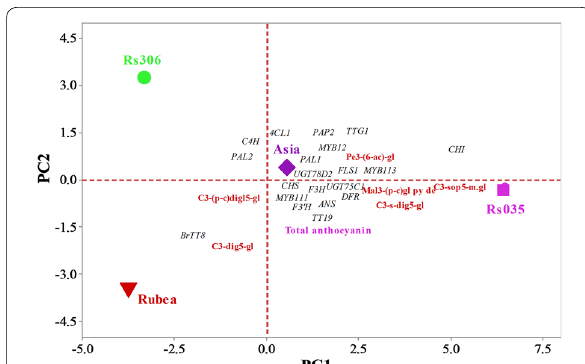
Fig. 5 Biplot of total and constituent anthocyanin contents and the expression of anthocyanin biosynthesis pathway genes in four Brassica lines (Asia, Rubea, Rs035, and Rs306), determined using a principle component analysis (PCA). Genotype text color reflects the visual phenotype of the leaves. Blue and italic texts denote anthocyanin components and gene names, respectively.